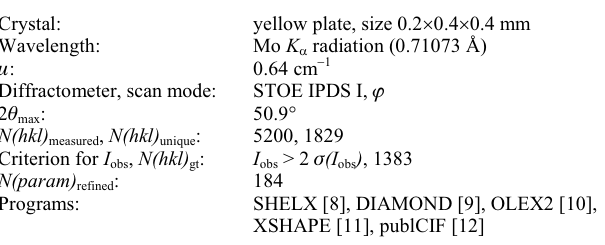
Table 1. Data collection and handling.